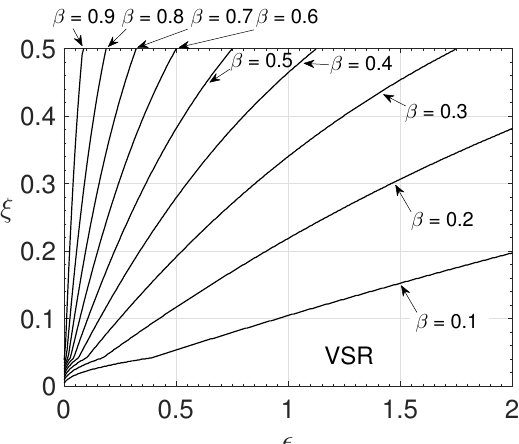
Figure 14. Valid solution region for different β values with (cid:101) and ξ - Re = 1000 and Wi = 3.0.